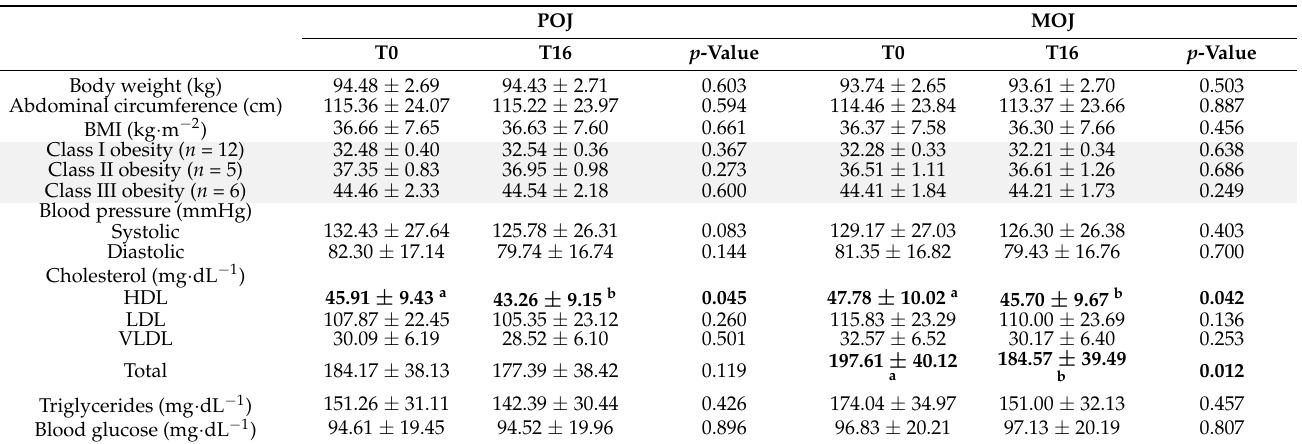
Table 2. Anthropometric variables, biochemical parameters, and intestinal permeability markers of the participants before (T0) and after (T16) Pera and Moro orange juice